Question: What type of chart is this?
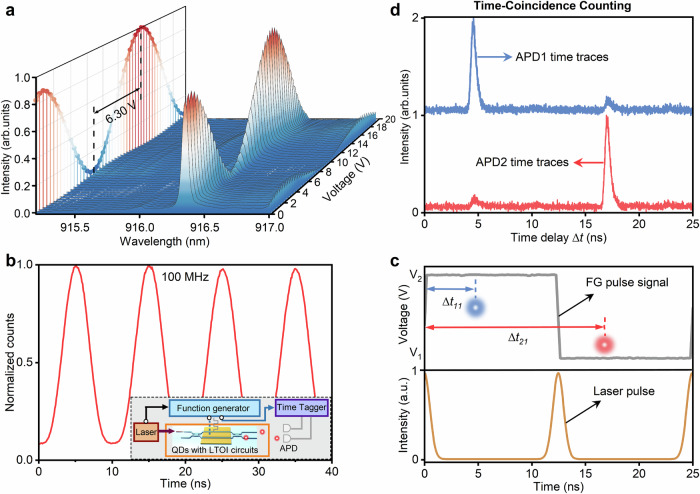
Answer: line